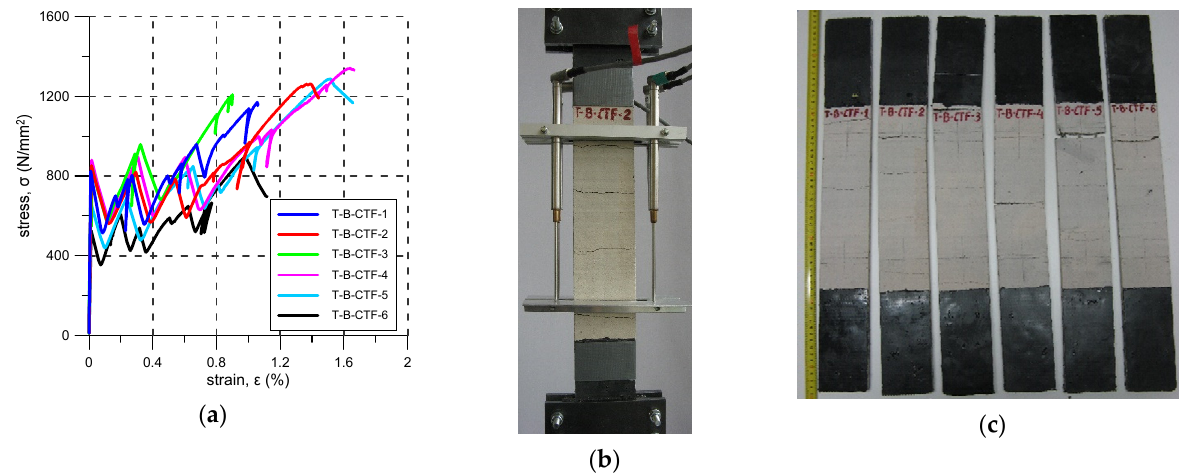
Figure 5. B-CTF test results: ( a ) stress-strain curves; ( b ) crack pattern; ( c ) specimens after the test. Table 5. B-CTF test results.